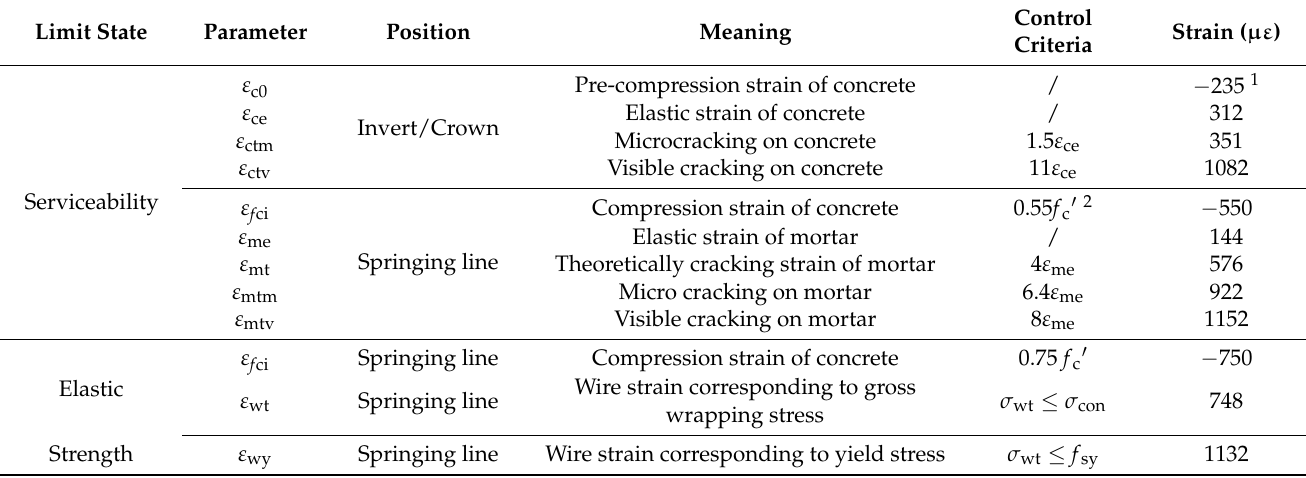
Table 5. Calculation results of the control